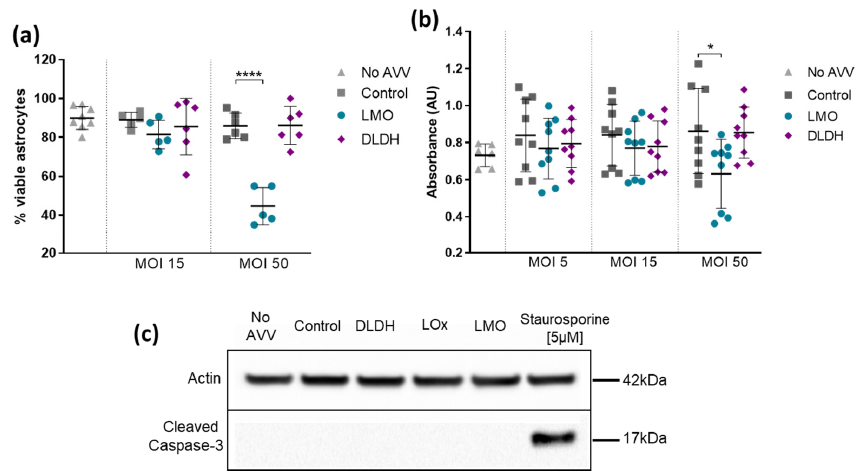
Figure 3. Viability of primary cultured astrocytes transduced with LMO and DLDH. Non-transduced astrocytes (No AVV) and astrocytes transduced with AVV-sGFAP-EGFP (Control), AVV-sGFAP-LMO-IRES-tdTomato (LMO), or AVV-sGFAP-DLDH-IRES-tdTomato (DLDH) at different MOIs were compared with regards to cell viability. ( a ) Trypan Blue exclusion assay; sample sizes n = 8 (No AVV), n = 5 (Control MOI15, LMO MOI15, LMO MOI50), n = 6 (Control MOI50, DLDH MOI15, DLDH MOI50). ( b ) XTT assay; sample sizes n = 6 (No AVV), n = 9 all other conditions. Cytotoxicity was observed only with transduction of LMO at MOI 50. **** p < 0.0001, * p < 0.05, one way ANOVA with Tukey multiple comparison test. ( c ) Absence of caspase 3 activation in primary astrocytes transduced with the novel tools as compared with astrocytes incubated with Staurosporine [5 µ M] for 3 h.